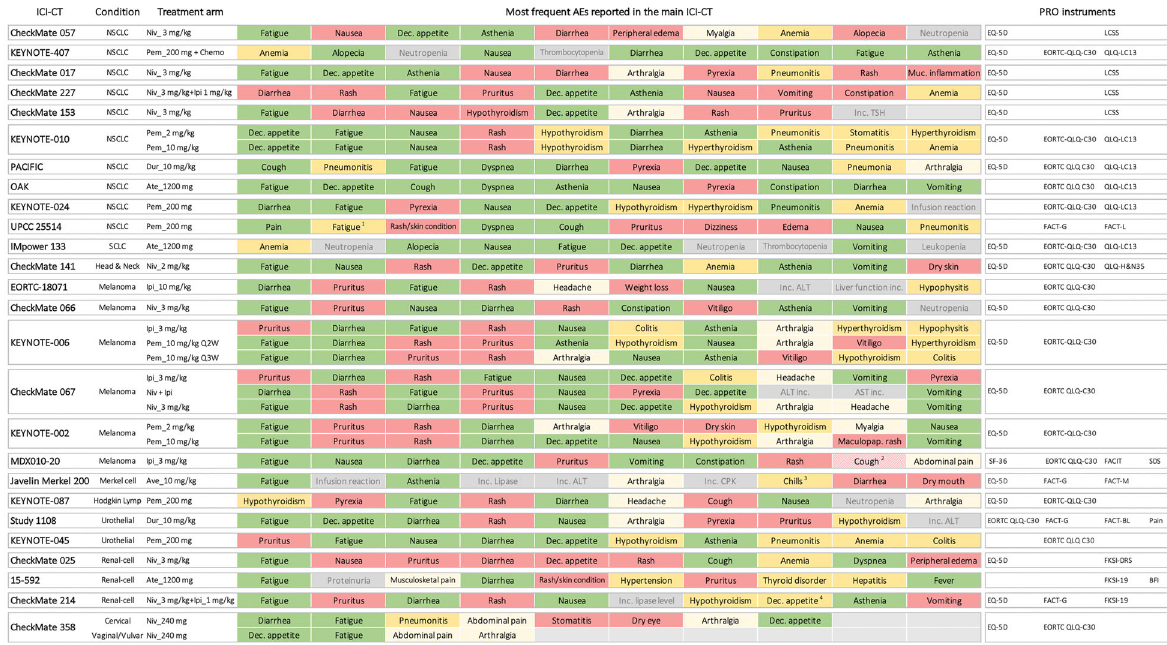
Fig. 3 Comparison of PRO instruments ’ symptom-related content and AEs reported in ICI-CTs with published PRO results ( n = 26). The most frequently reported AEs (any grade) are shown for the 26 ICI-CTs identified. AE frequency (most common to least common) is depicted from left to right respectively. Symptom-related content from each PRO instrument was compared to the AEs in the corresponding trial arm. The PRO instruments used in each ICI-CT is shown. For a detailed PRO instrument content, see Table S8. Green: AEs covered; Yellow: AEs partially covered; Light yellow: AEs partially covered related to specific types of pain; Red: AEs not covered. Laboratory tests results (grey) were not included in calculations. “ Asthenia ” was considered covered by “ fatigue ” following the National Cancer Institute toxicity grading scale version 3 that included asthenia, lethargy, and malaise under the umbrella of “ fatigue ” . (1) “ Fatigue ” was considered partially covered because the term included in the FACT-G was “ lack of energy ” ; (2) While the study protocol announced the use of SF-36, EORTC QLQ-C30, FACIT-Fatigue, and SDS questionnaires, only results from the EORTC QLQ-C30 were reported in the full- text publication. “ Cough ” would be covered by the SDS instrument; (3) “ Chills ” was partially covered as related to “ fever ” , included in the FACT-G; (4) “ Dec. appetite ” was considered as partially covered by the term “ good appetite ” in the FKSI-19. Ipi, Ipilimumab; Niv, Nivolumab; Pem, Pembrolizumab; Ate, Atezolizumab; Dur, Durvalumab; Inc., increased; Dec,